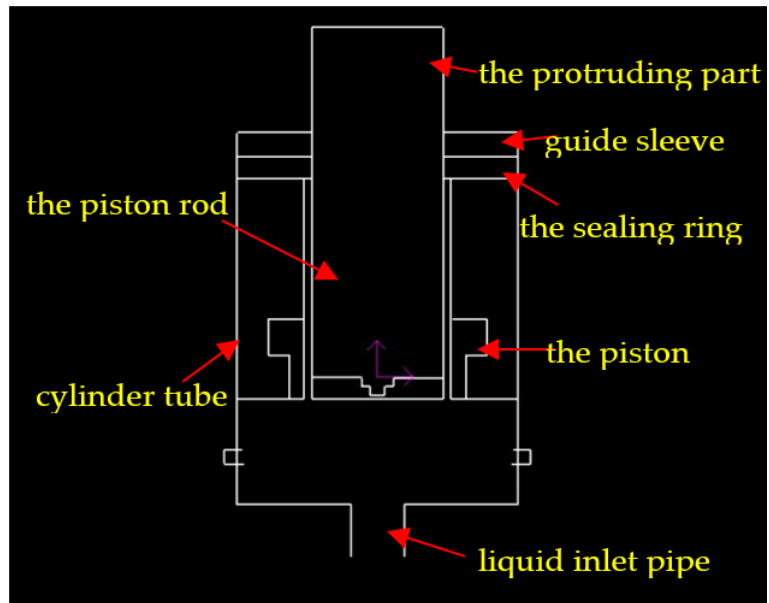
Figure 1. A schematic diagram of the motion of the piston rod.